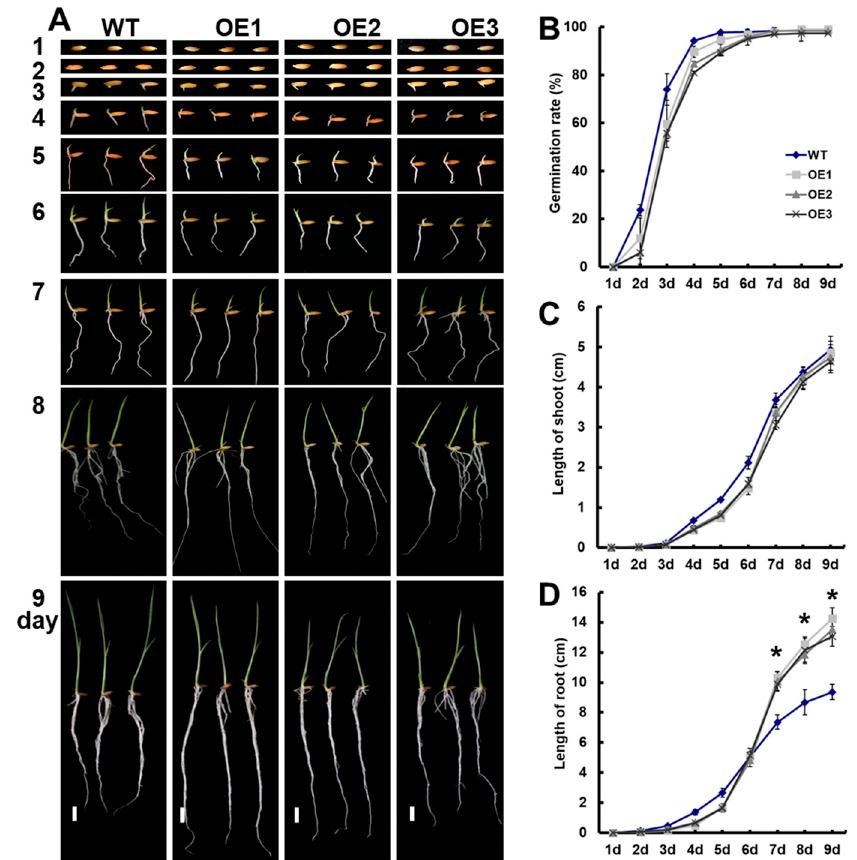
Figure 1. Overexpression of OsNRT2.1 affects root growth at the seedling stage under 0.25-mM NH 4 NO 3 conditions . Rice seedlings were grown in a quarter concentration of nutrient solution containing 0.25 mM of NH 4 NO 3 from the beginning. The nutrient solution was replaced daily. ( A ) Seed germination in wild type (WT) and transgenic plants. Scale bars = 1 cm. ( B ) Seed germination rate, ( C ) shoot length, and ( D ) root length of WT and transgenic plants. Error bars: SE ( n = 10). Significant differences between transgenic lines and WT are indicated by asterisks ( p < 0.05, one-way ANOVA). − Under 0.5-mM NO 3 conditions, the total root length of transgenic plants increased by